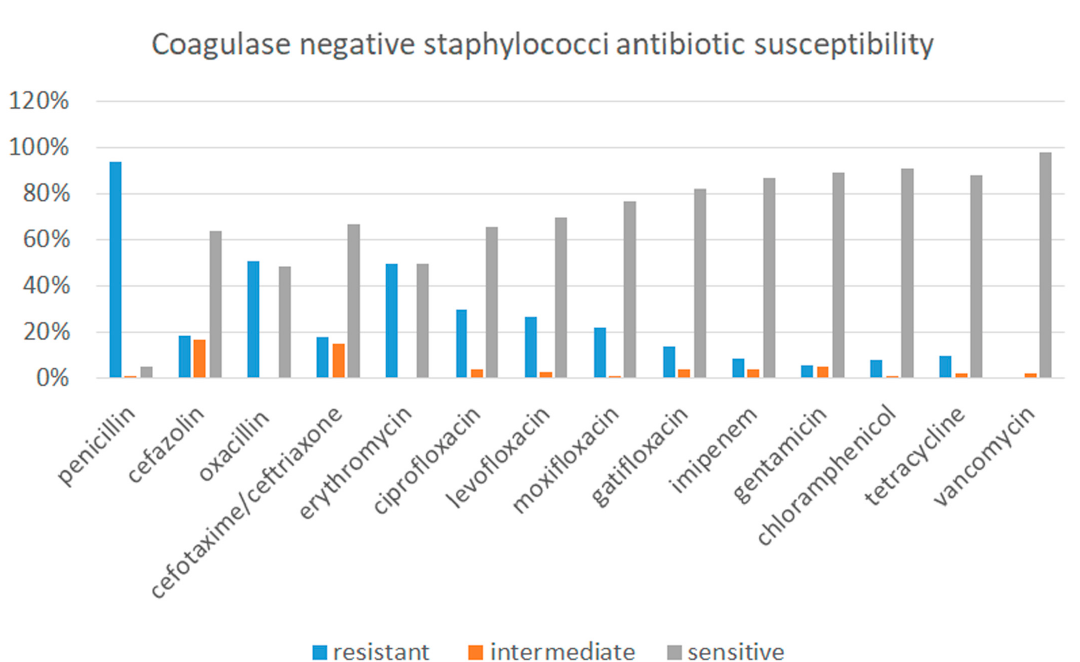
Figure 2. Antibiotic susceptibility of the isolated coagulase negative staphylococci.